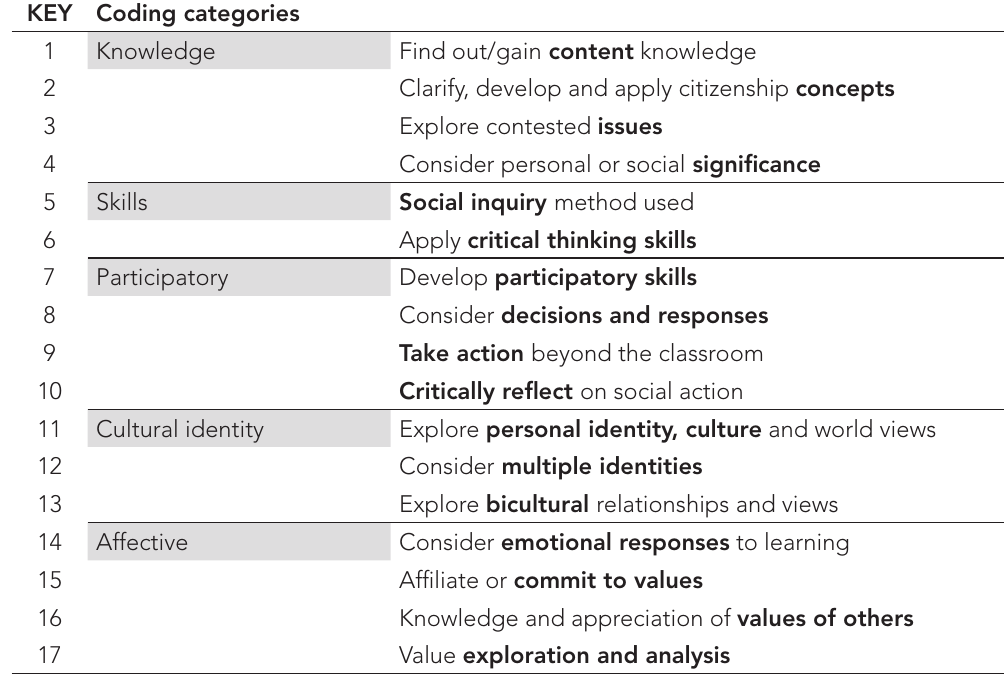
Table 1: Coding categories for civics and citizenship education outcomes KEY Coding